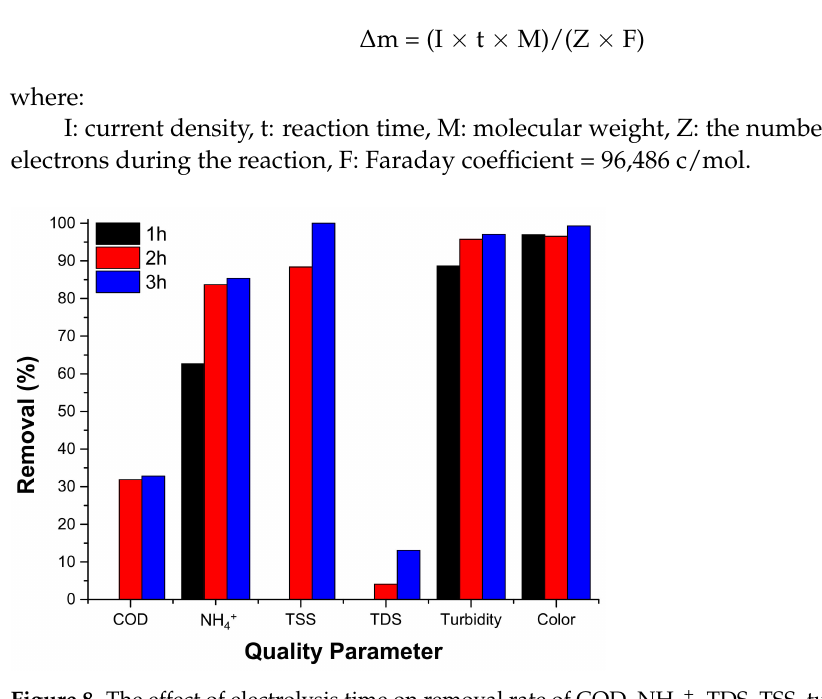
Figure 8. The effect of electrolysis time on removal rate of COD, NH 4 + , TDS, TSS, turbidity, and color (pH = 7.5; current density = 64 mA/cm 2 ; inter-electrode distance = 1.5 cm; temperature = 20 ◦